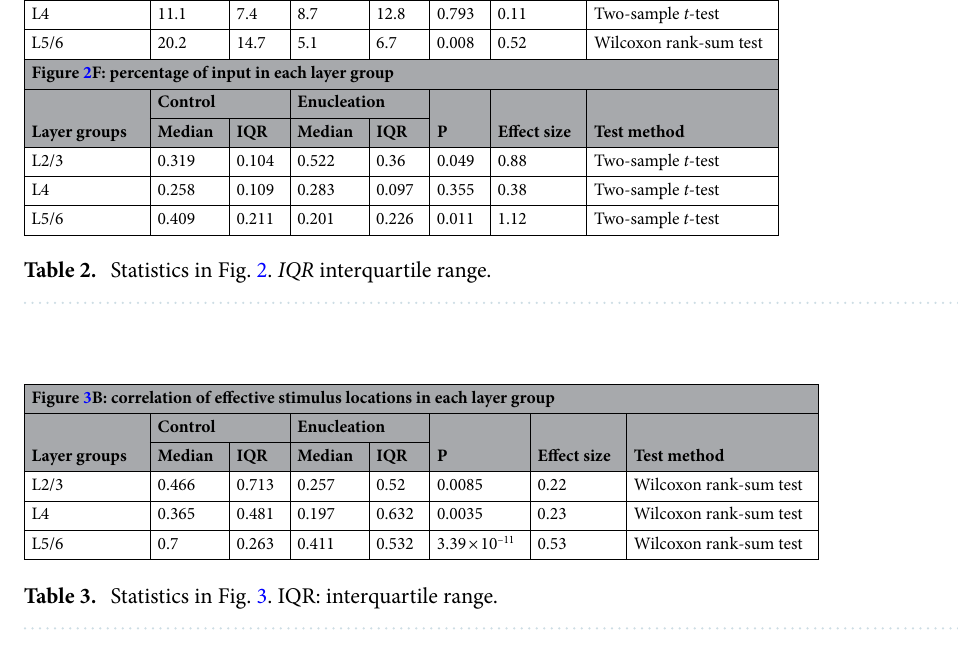
Figure 2F: percentage of input in each layer group